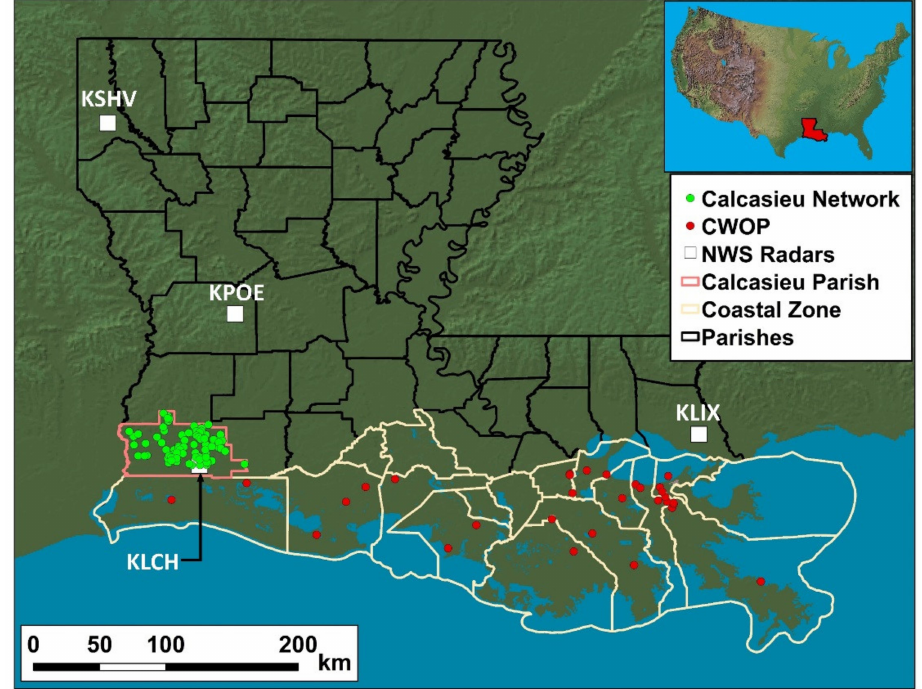
Figure 1. Map showing the Calcasieu Parish network (green dots) and the Citizen Weather Observer Program (CWOP) network (red dots) over coastal Louisiana. The white squares depict the locations of the NWS Doppler radars (WSR-88D) in Lake Charles (KLCH), Slidell (KLIX), Fort Polk (KPOE) and Shreveport